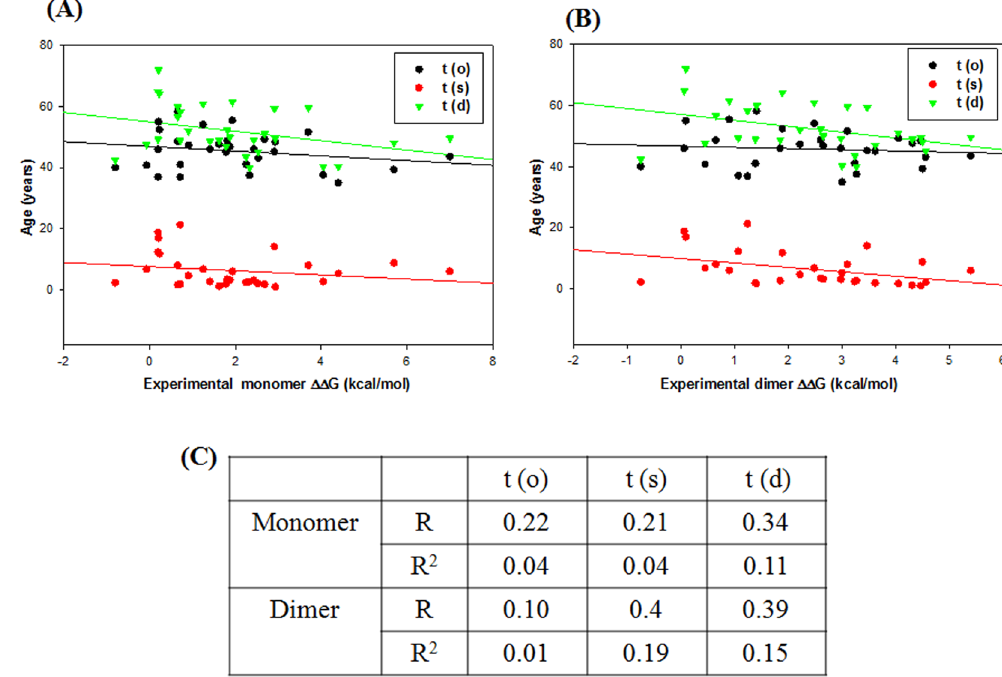
Figure 5. Correlation between patient’s disease onset, t(o), survival time, t(s), and age of death, t(d) (in years) of ALS patients carrying 30 SOD1 variants vs. the corresponding experimental monomer ( A ) and dimer ( B ) stability changes (kcal/mol). ( C ) Table lists linear regression coefficient, R and R 2 value for